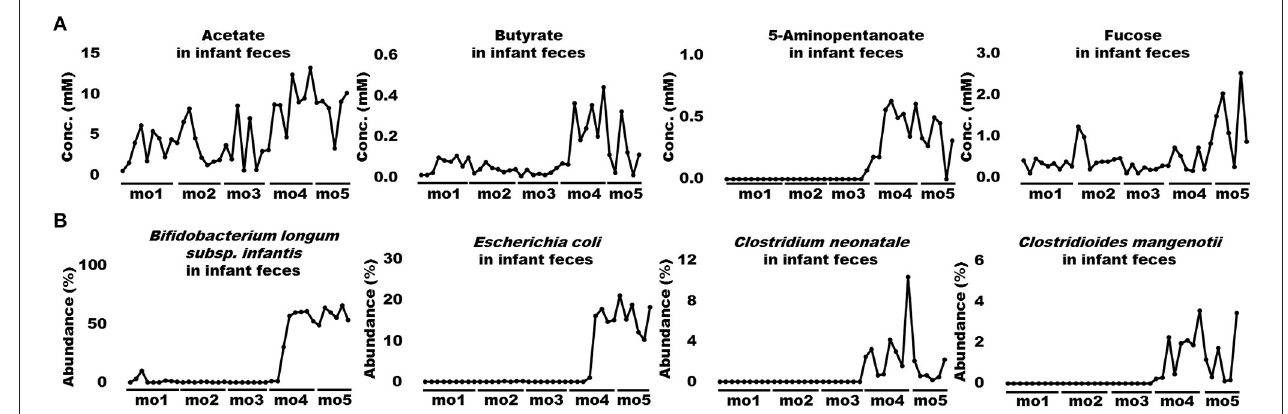
FIGURE 5 | Changes in bioactive milk components, the microbiome, and metabolites in infant feces with high similarity in cluster B. (A) Acetate, butyrate, 5-aminopentanoate, and fucose levels in infant feces. (B) Bifidobacterium longum subsp. infantis , Escherichia coli , Clostridium neonatale , and Clostridioides mangenotii in infant feces. mo,